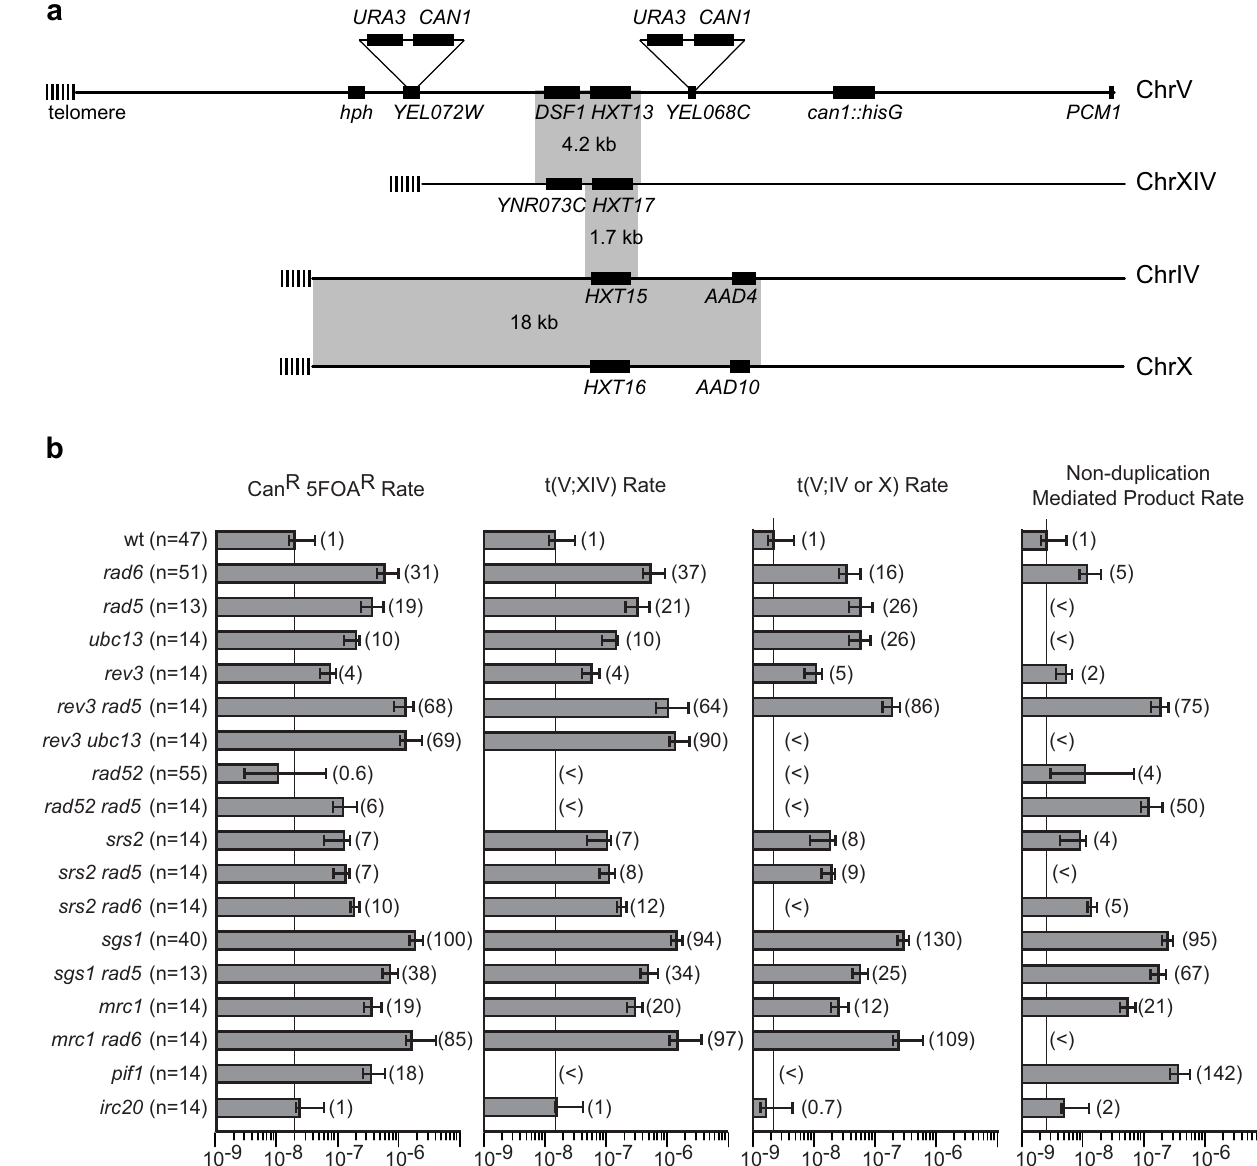
Figure 1. PRR defects result in increased rates of duplication-mediated translocations. A. The pre-duplication ( yel068c::CAN1/URA3 ) and post-duplication ( yel072w::CAN1/URA3 ) assays differ by whether or not they include the DSF1-HXT13 homology in the breakpoint region (the left arm of chromosome V between the CAN1/URA3 cassette and the most telomeric essential gene, PCM1 ). The hygromycin resistance marker is indicated by hph . Grey boxes indicate regions of homologies between the chromosomes. B. The rates of the total Can R 5FOA R product and the rates of t(V;XIV) and t(V;IV or X) translocations, and non-duplication-mediated GCR products in the yel072w::CAN1/URA3 assay are depicted in a bar graph. Error bars indicate 95% confidence intervals and the fold increase for each rate is displayed in parentheses, ( , ) indicates that no isolates of that class were identified. The number of isolates analyzed is shown in parentheses after the genotype. The numerical GCR rates are presented in Tables 1, 2, 4 and 5.